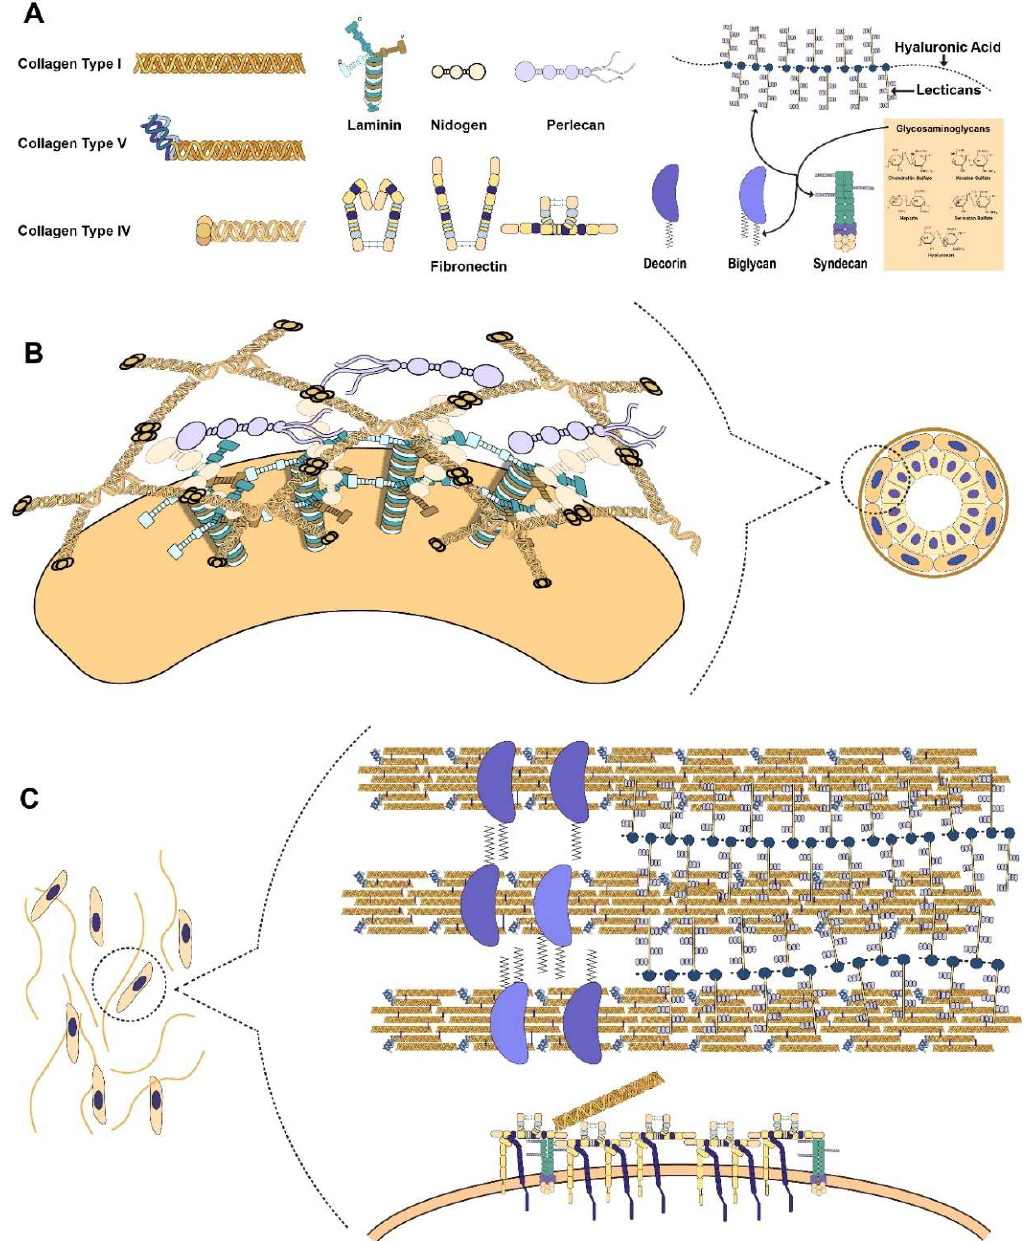
Figure 1. Unique ECM molecules and their organization in the basement membrane and interstitial stroma. Panel A (top) shows the unique components of the extracellular matrix. Panel B and C (middle) shows how these different collagens, proteoglycans, laminins, and fibronectin are organized within the basement membrane ( B ) and interstitial ECM ( C ). A breast acinus with epithelial cells is surrounded by myoepithelial cells and the basement membrane. In the basement membrane, the laminin is bound to the cell and forms a network through its long arms. It is then connected to the collagen IV network through nidogen and proteoglycans such as perlecan and agrin. Outside the basement membrane is the interstitial ECM where fibroblasts that produce and remodel the ECM can be found. In the interstitial stroma, collagen fibres are made up of fibrils composed of collagen I and collagen V. The different proteoglycans, such as decorin, biglycan, and hyalectans, holds the fibrils together to form a collagen fibre. Fibronectin is bound to the cell via integrins and syndecans. Once fibronectin is unfolded, it reveals cryptic binding sites for heparan sulfate proteoglycans (HSPGs) and collagen. Modified and combined figures from Mouw et al. 2014 [15] and Hohenester and Yurchenco 2013 [34].